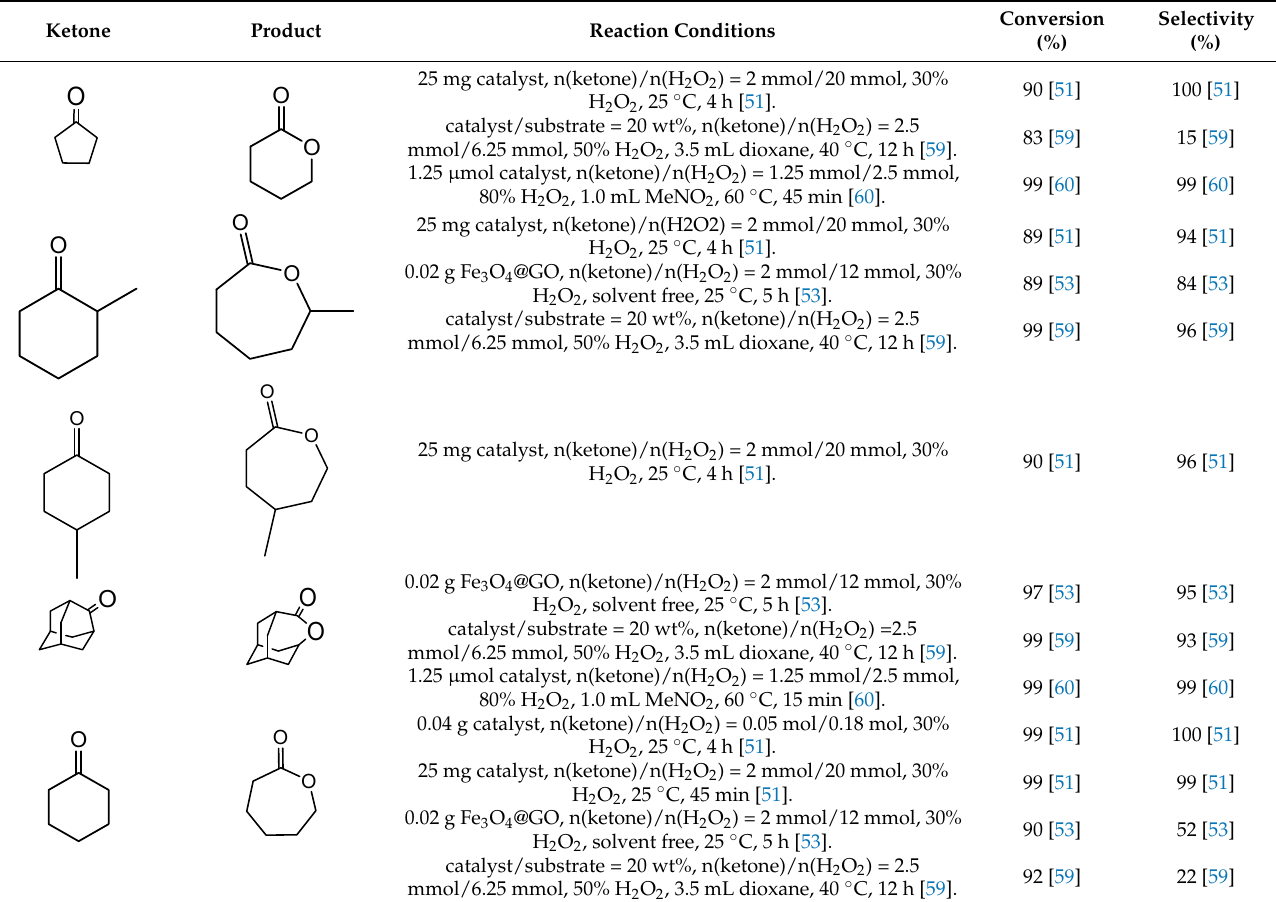
The catalytic mechanisms of Bronsted acids and Lewis acids are different. The good catalytic performance of transition metal oxides can be attributed to the coordination of the Lewis acid center of metal with carbonyl oxygen, and the reaction with hydrogen per- oxide to form peroxy acids. The high catalytic activity of MoO 3 is due to its reaction with hydrogen peroxide to form peroxy acids. The possible reaction process is shown in Figure 7. Figure 7. A possible mechanism for Baeyer–Villiger oxidation over transition metal oxides [59].